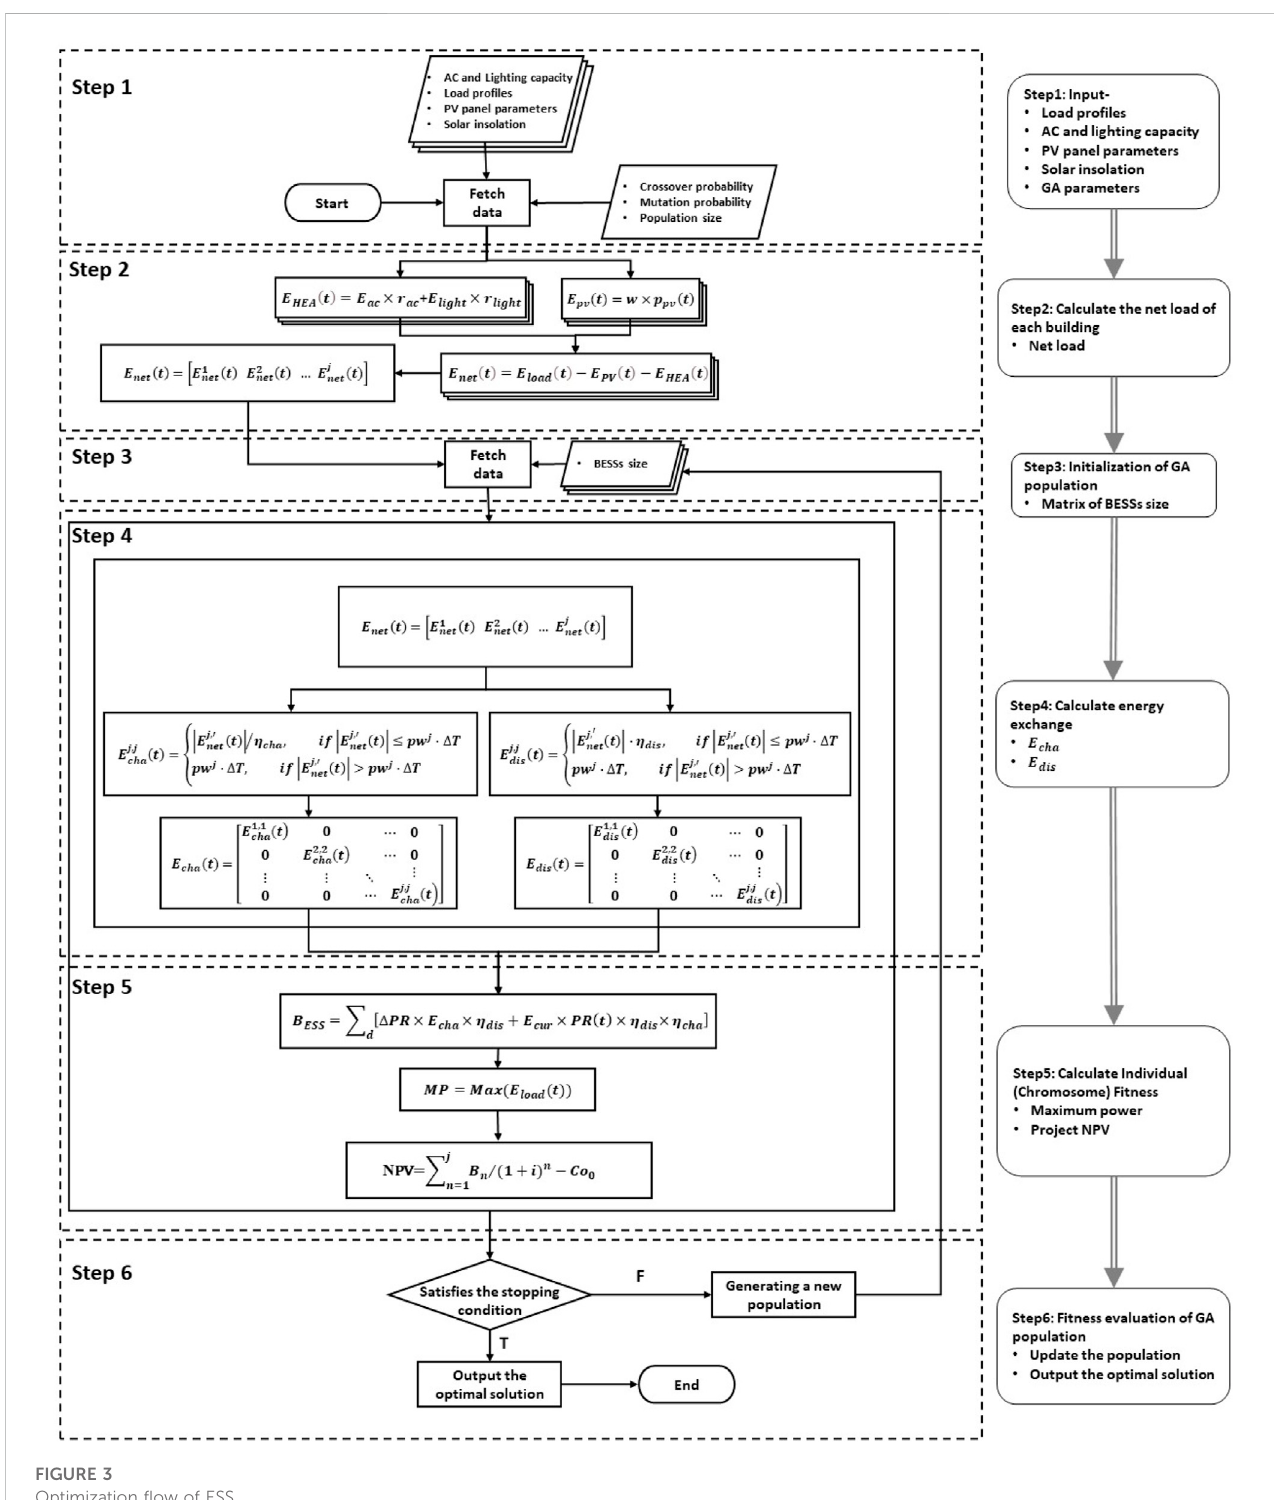
FIGURE 3 Optimization fl ow of